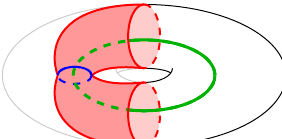
Figure 7. The configuration obtained by cutting and gluing two disk branes together at a disk of radius r = r ∗ (shown in blue). This may be interpreted as the embedding of two disk branes in a torus such that they intersect without “hiding” the